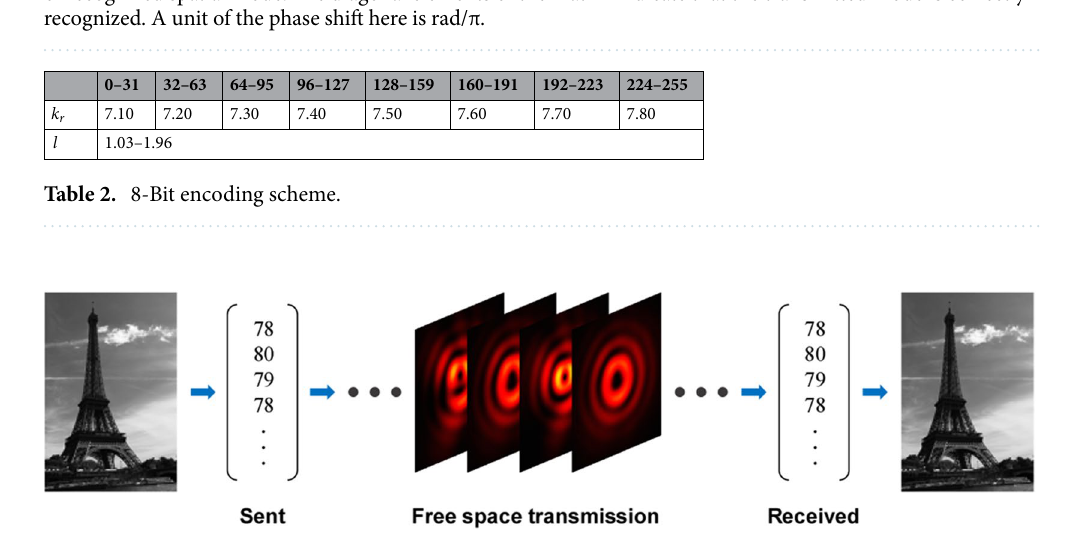
Figure 8. Image transmission in the proposed optical link. An Eiffel Tower gray image of 100 × 150 pixels is transmitted and received. An error rate defined as the ratio of the number of incorrect pixels to the total number of pixels was